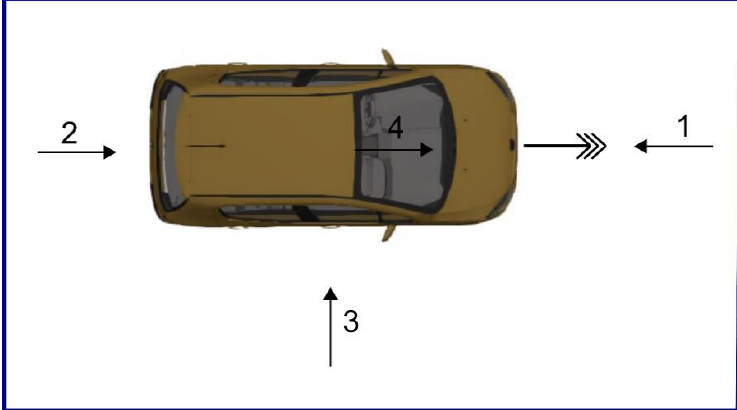
Figure 1. Observation positions in Experiment I: 1—Front view; 2—Back view; 3—Side view; 4— Figure1. ObservationpositionsinExperimentI:1—Frontview; 2—Backview; 3—Sideview; 4—Driver’s Driver’s seat perspective. seat